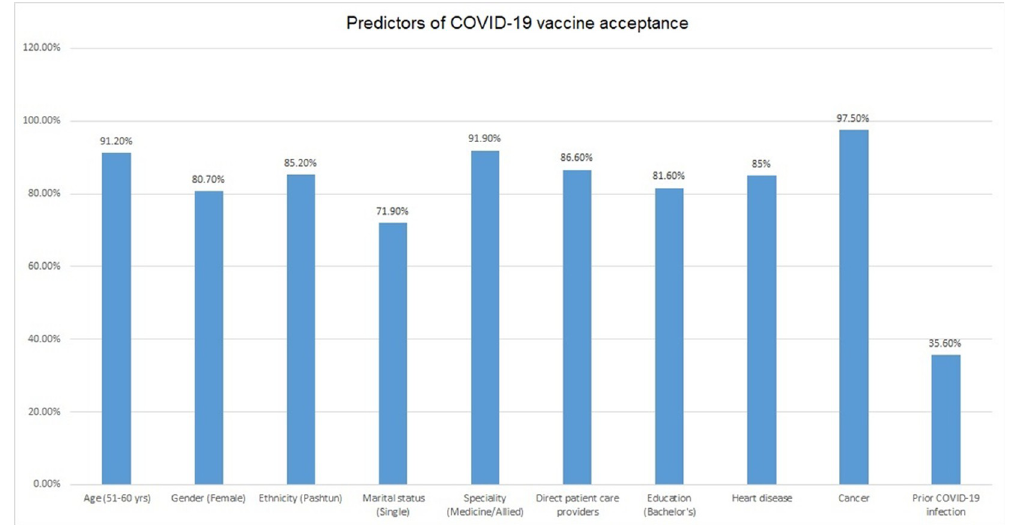
Fig 3. Logistic regression analysis demonstrating predictors for COVID-19 vaccine